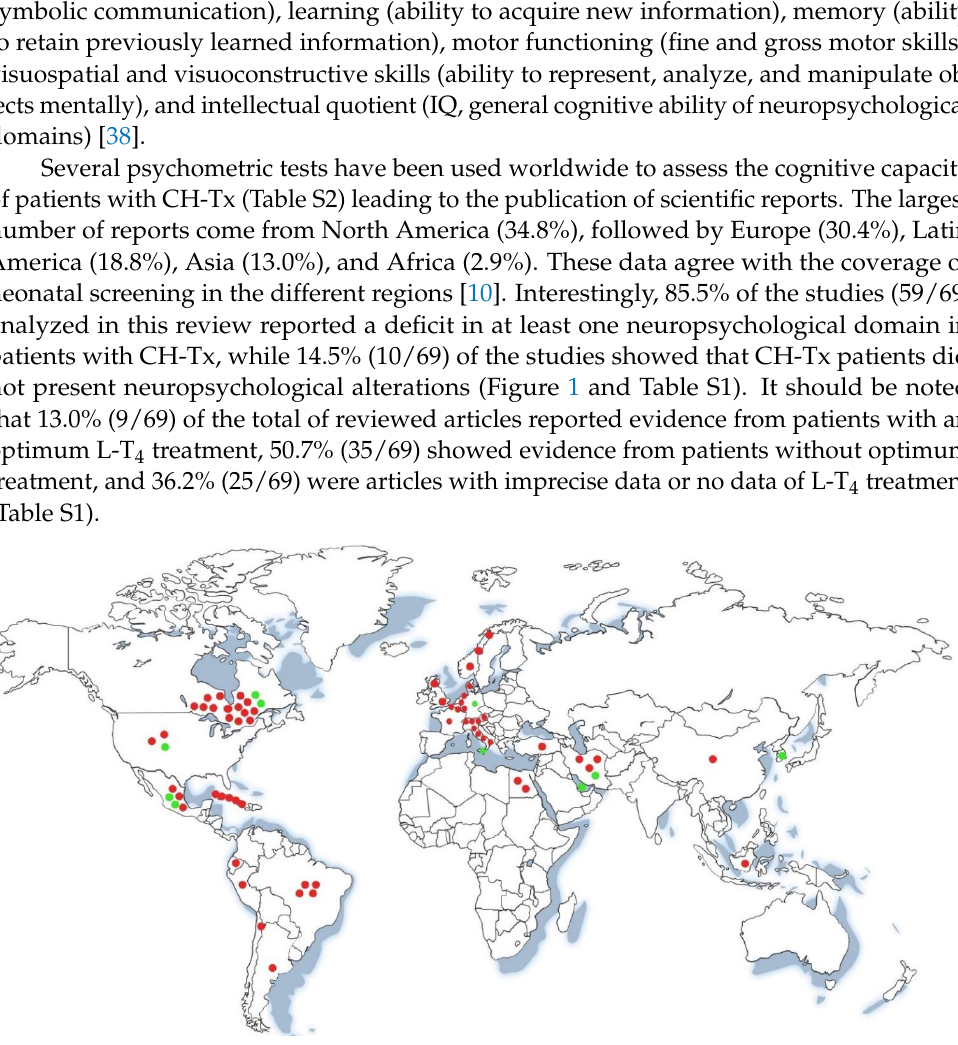
Figure 1. Worldwide distribution of scientific reports on neuropsychological profiles of CH-Tx patients. The red dots indicate reports of CH-Tx patients with a deficit in at least one neuropsychological domain. The green dots indicate reports of CH-Tx patients who did not present neuropsychologi- cal